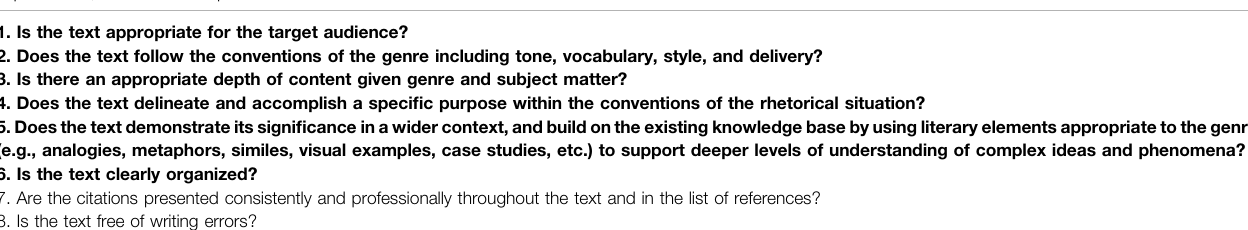
TABLE 2| Rubric items usedtoassessSciWriteand non-SciWritewrittenproducts forpublicaudiences, arrangedfrom “ higher-order concerns ” to “ lower-order concerns ” . Rubric items in bold address higher-order concerns. Written products were assessed on a scoring scale from 1 to 3: “ does not meet expectations, ” “ approaches expectations, ” and “ meets expectations. ”